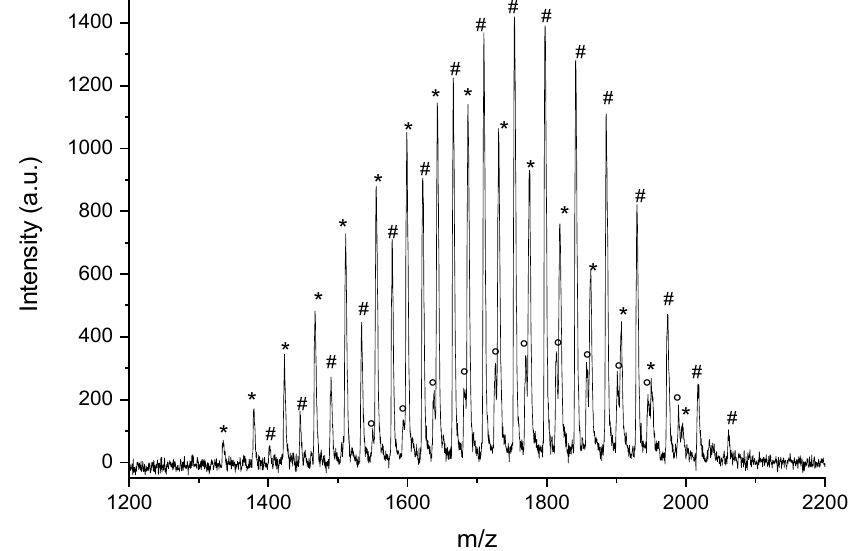
Figure 1. MALDI-TOF spectrum of P(PEG350) 3 , mtx DCTB. The symbols on the top of the peaks indicate the following species: #, [M]H + ; *, [M]Na + ; °, [M]K + .